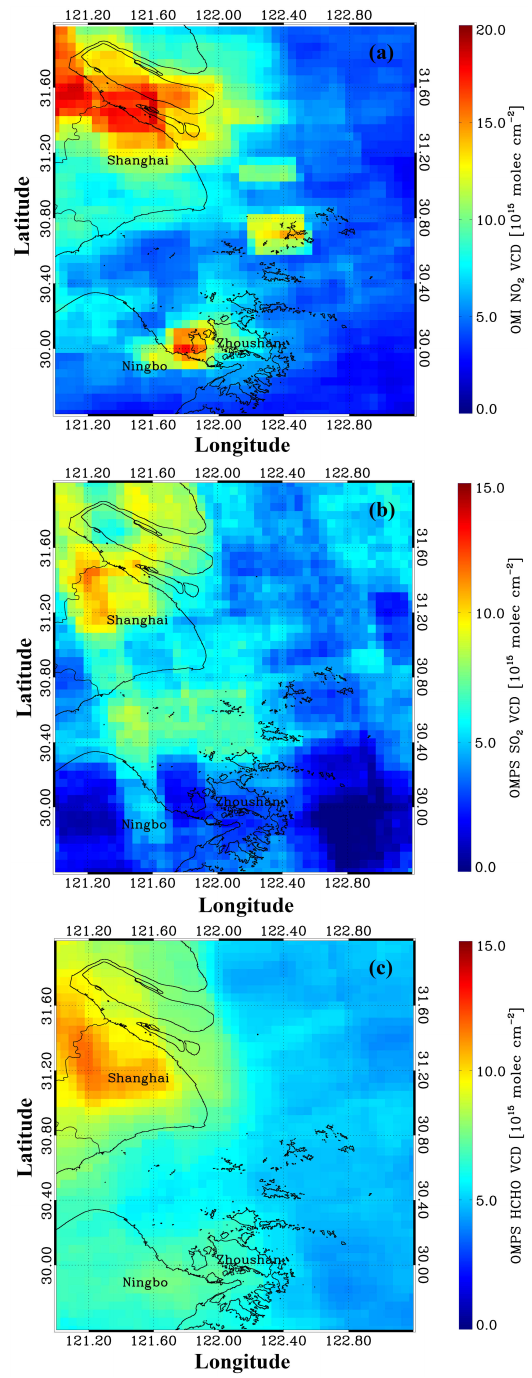
Figure 9. The monthly averaged spatial distributions of the trace gas VCDs of (a) NO 2 , (b) SO 2 , and (c) HCHO of the OMI and OMPS satellite observations in June 2017.